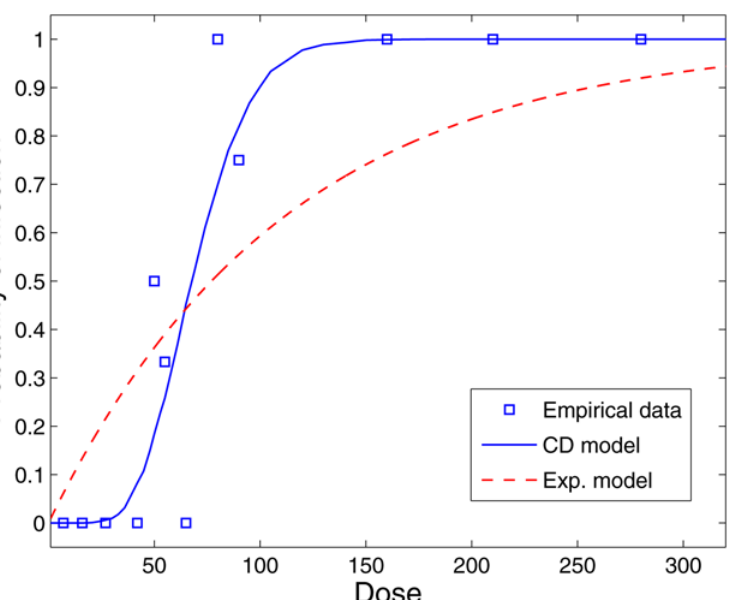
Figure 4. Dose-response curves based on the Exponential Model ( EM ) and the Cumulative Dose model ( CD ) compared to the experimental dataset for Poliovirus type 1 (squares). The estimated parameters are ^ rr ~ 9 : 0 | 10 { 3 for the Exponential model [3] and h P , d P , a I , c I , d I , l I f g ~ 1 : 0151, 1 : 0431, 16 : 8190, 0 : 7831, 1 : 7881, 1 : 4041 f